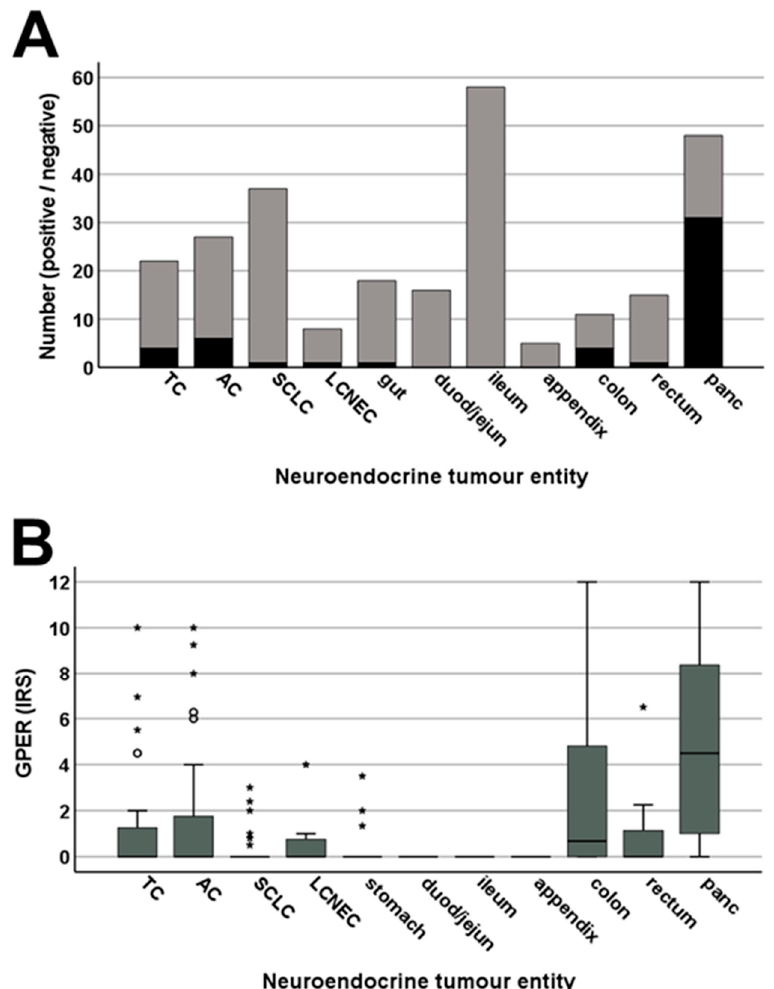
Figure 7. Expression profile of GPER in different bronchopulmonary and gastroenteropancreatic neuroendocrine tumour entities. ( A ) Number of GPER-positive (black) and GPER-negative cases (grey) within the different neuroendocrine tumour entities. Tumours were only considered positive at immunoreactivity score (IRS) values ≥ 3. ( B ) GPER expression levels (IRS values) in the different neuroendocrine tumour entities. Median values, upper and lower quartiles, minimum and maximum values, and outliers are shown. Outliers were defined as follows: circles, mild outliers (data points between 1.5 and 3 times above the upper quartile or below the lower quartile); asterisks, extreme outliers (data that fell more than 3 times above the upper quartile or below the lower quartile). TC, typical carcinoid of the lung; AC, atypical carcinoid of the lung; SCLC, small cell lung cancer; LC-NEC, large-cell neuroendocrine carcinoma of the lung; gut, gastroenteropancreatic neuroendocrine tumour (GEP-NEN) from the gut; duod/jejun, GEP-NEN from the duodenum or jejunum; ileum, GEP-NEN from the ileum; colon, GEP-NEN from the colon; rectum, GEP-NEN from the rectum; panc, pancreatic neuroendocrine tumour.